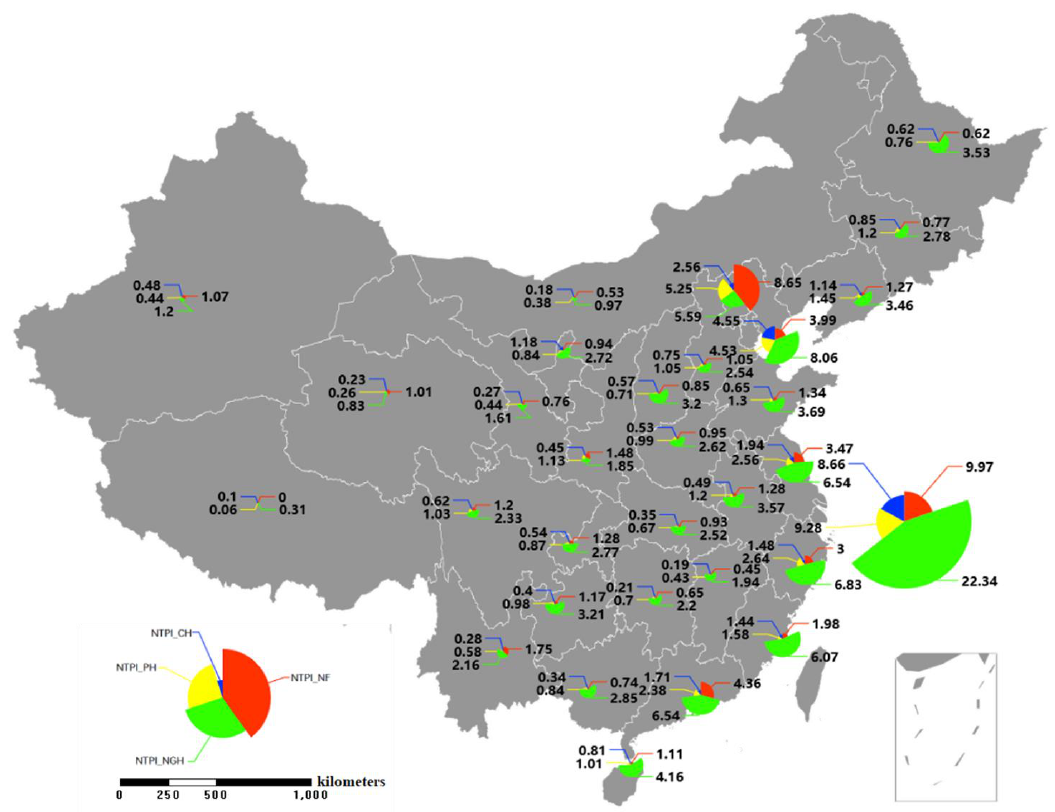
Figure 11. The spatial distribution of NTPI for four highway grades.